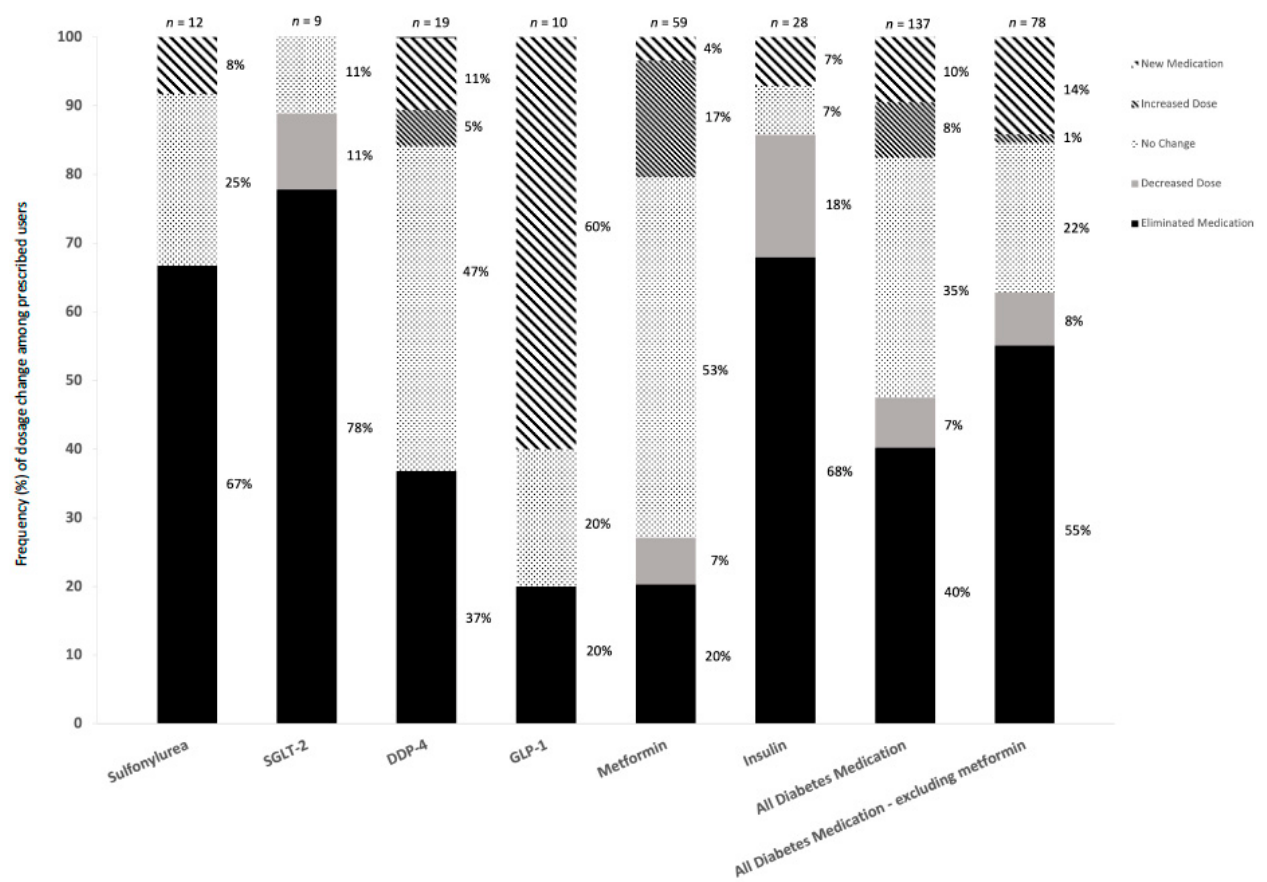
Figure 3. Frequency of medication dose changes by drug class. Bars represent total number and relative frequency of reported dose changes.